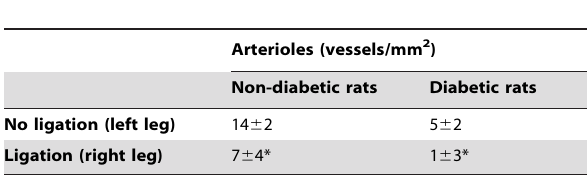
Table 1. Quantitative analysis of arteriole density in the limbs of diabetic and non-diabetic